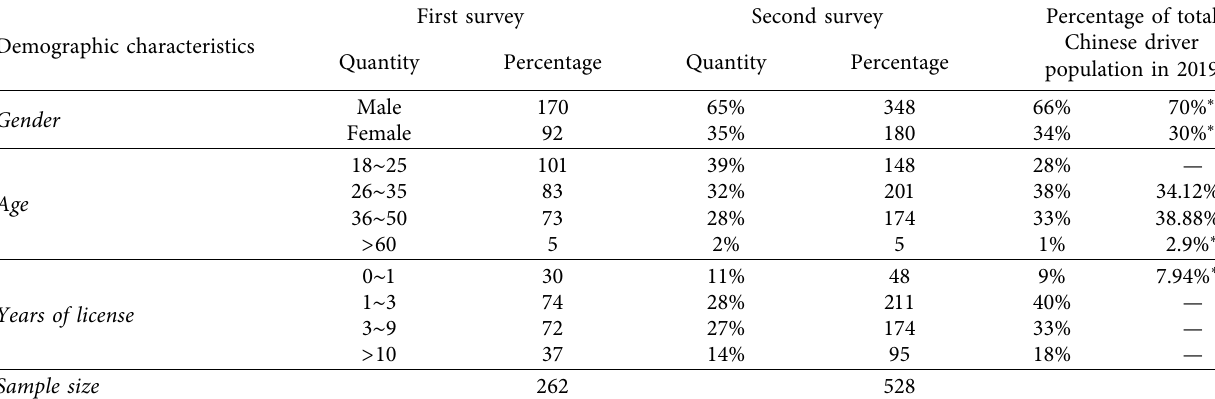
Table 1: Demographic characteristics of survey subjects.